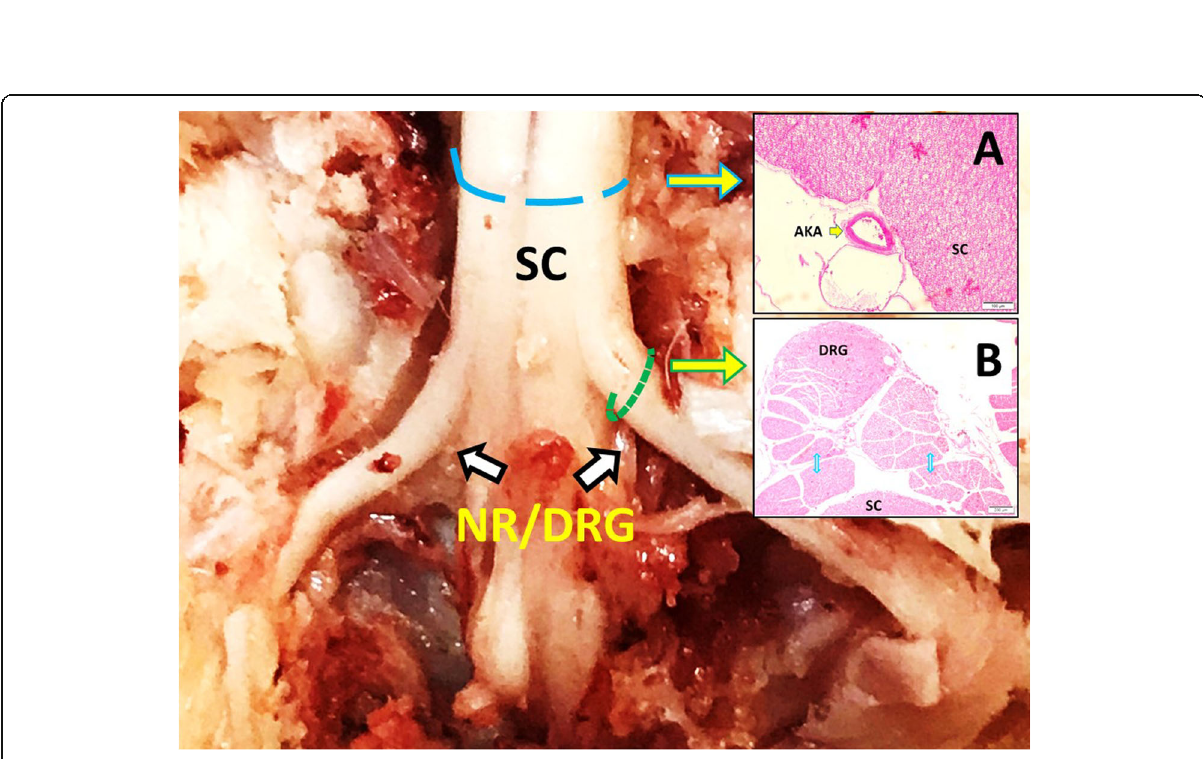
Fig. 5 Anatomical representation of sacral spinal cord (SC), pudendal nerve roots (NR) and dorsal root ganglions (DRG) (base); spinal cord section at Onuf ’ s nucleus level (blue circle) and the histopathological appearance of the spinal cord (SC), the artery of Adamkiewicz (AKA) (LM, H&E, × 10/ A); and dorsal root ganglion neurons (DRG), nerve axons (blue arrows) and spinal cord (SC) (LM, H&E, ×